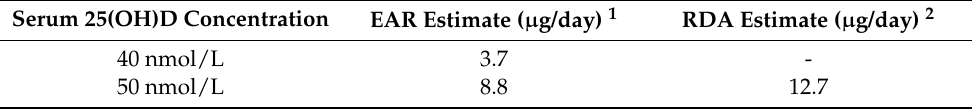
Table 2. Comparison of the EAR and RDA estimates using two different serum 25(OH)D targets.